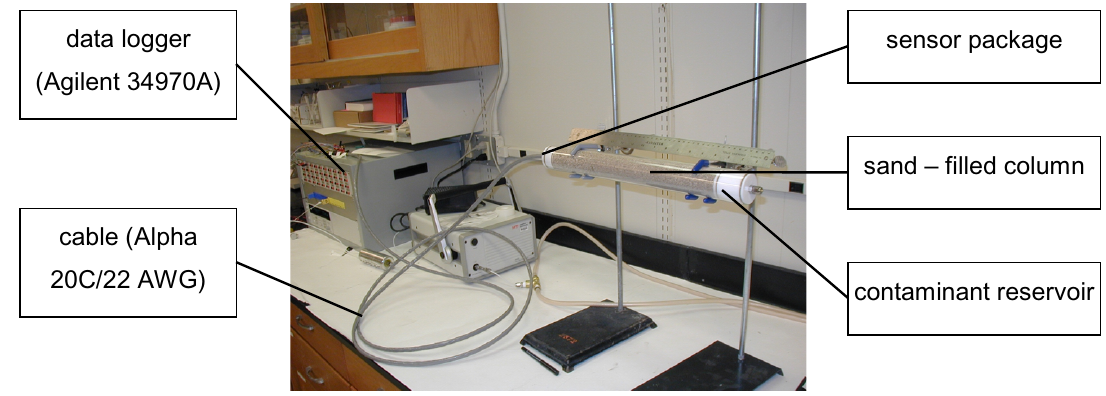
Figure 6. One-dimensional column experiment used to test chemiresistor sensor package in porous